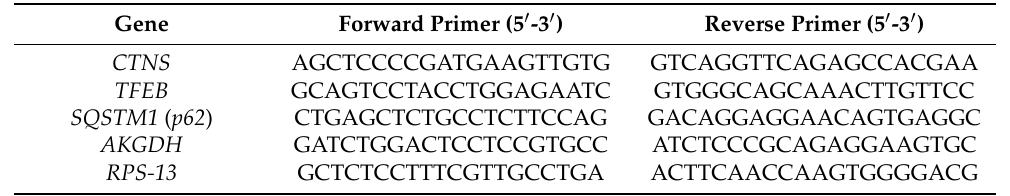
Table 1. Primer sets used for quantification by Real-time